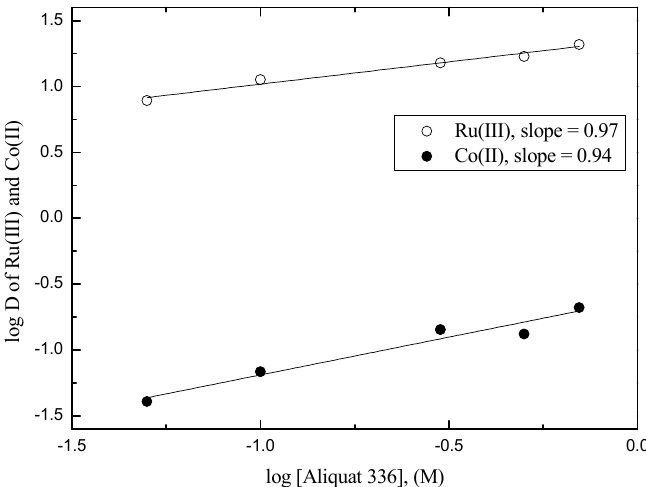
Figure 2. Effect of Ru(III) concentration on the separation of Co(II) from 3 M HCl solution. ([Extractant] = 0.1 M and [Co(II)] = 100 mg/L).